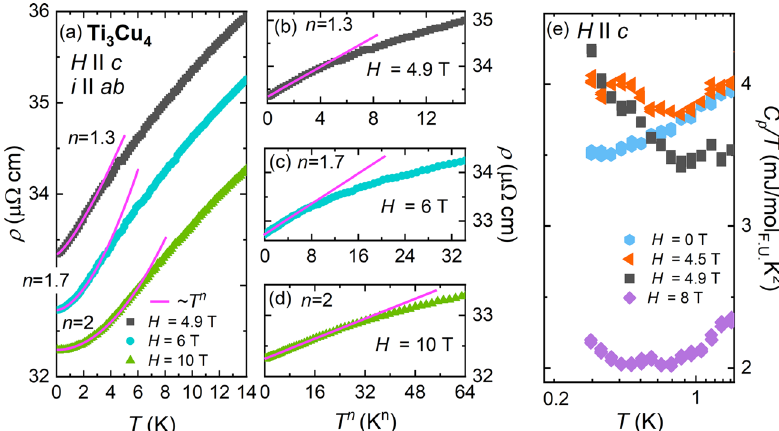
Fig. 8 Evidence for non-Fermi liquid behavior in Ti 3 Cu 4 . a Temperature dependent resistivity ρ measured for temperatures 50 mK < T < 14 K for applied magnetic fi elds H greater or equal to the critical fi eld H c (closed symbols). Solid lines are fi ts to the lowest temperature data to the equation ρ = ρ 0 + AT n , where n = 1.3 (non-Fermi liquid), 1.7 (intermediate) and 2 (Fermi liquid), for H = 4.9 T, 6 T, and 10 T, respectively. ρ ( T ) data (symbols) are plotted against T n for ( b ) n = 1.3 and H = 4.9 T, ( c ) n = 1.7 and H = 6 T, and ( d ) n = 1.7 and H = 10 T. The pink lines are fi ts that show a single power corresponding to n describe the resistivity for well over a decade in T for all fi elds. e Heat capacity scaled by temperature C p / T on a semi-log T scale from 0.3 K < T < 1.5 K for